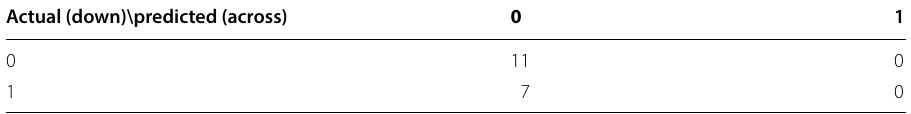
Table 8 Confusion matrix using all 441 features Actual (down)\predicted